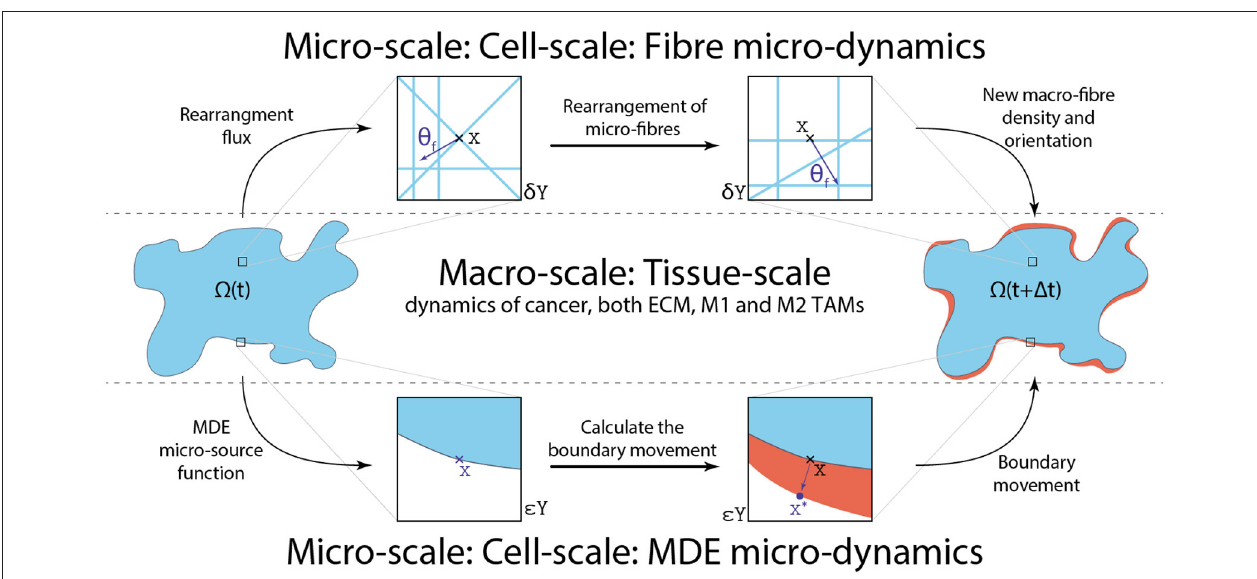
FIGURE 5 | Schematics of the four links between the macro and both micro-scales as well as how they are linked